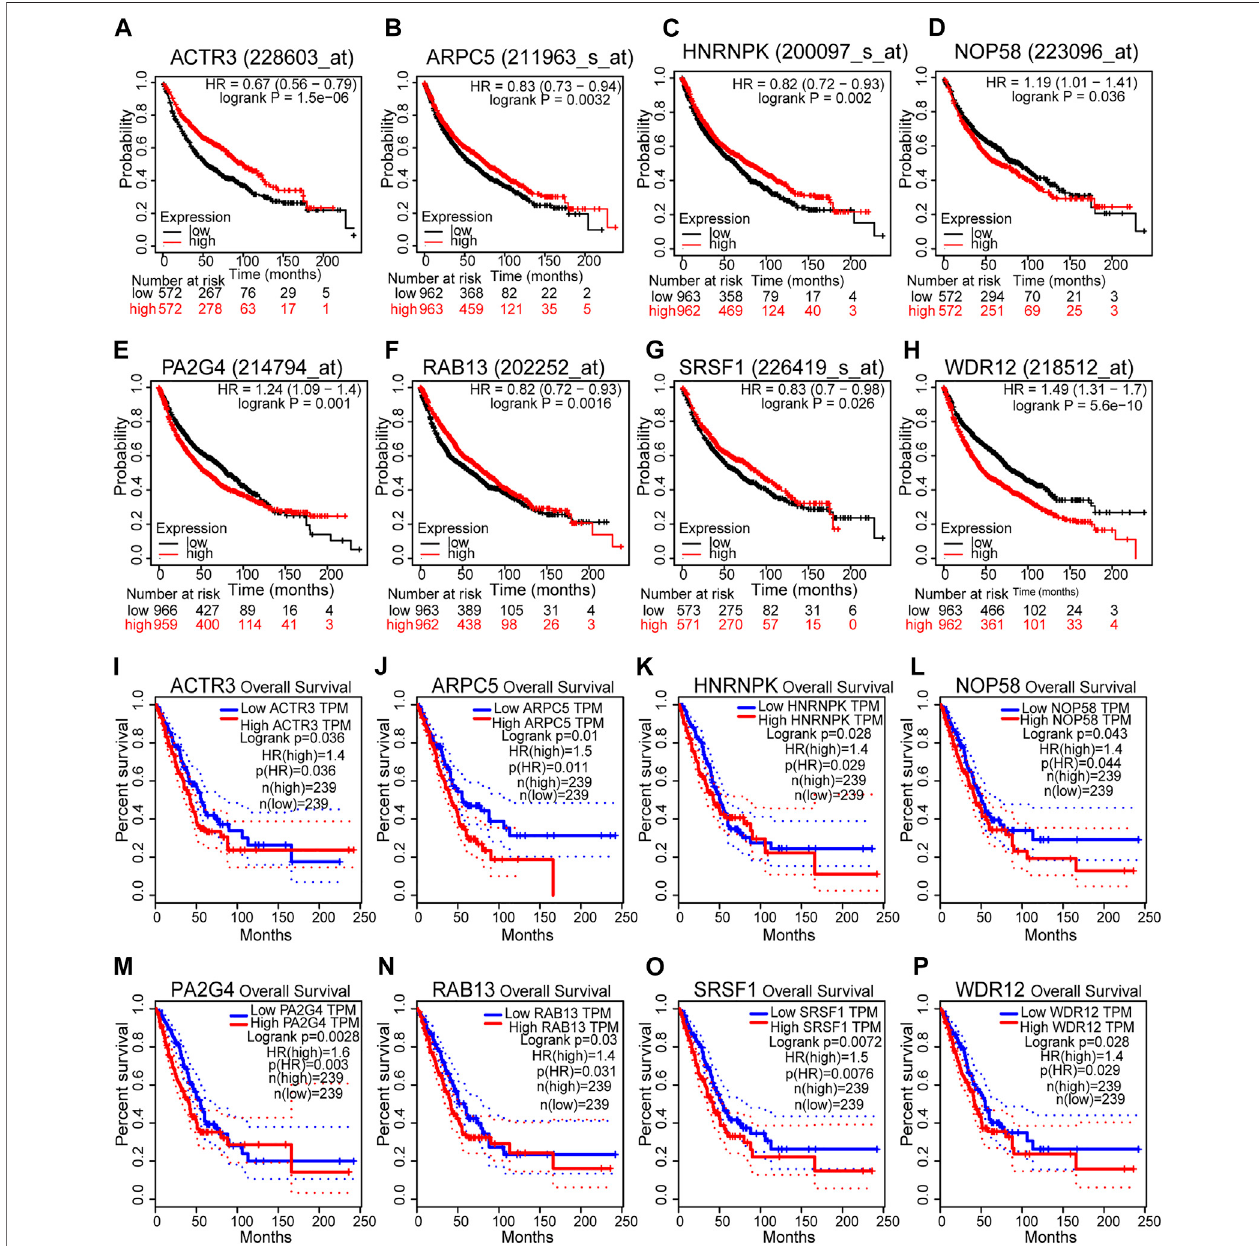
FIGURE 6 | Survival analyses of the eight hub gene candidates identi fi ed. (A – H) Overall survival of the eight hub gene candidates in lung adenocarcinoma (LUAD) based on Kaplan – Meier plotter. (I – P) Overall survival of the eight hub gene candidates in LUAD based on the Gene Expression Pro fi ling Interactive Analysis (GEPIA) database. p < 0.05 was considered to indicate a statistically signi fi cant difference. ACTR3, actin-related protein 3; ARPC5, actin-related protein 2/3 complex subunit 5; HNRNPK, heterogeneous nuclear ribonucleoprotein K; NOP58, NOP58 ribonucleoprotein; PA2G4, proliferation-associated 2G4; RAB13, RAB13 member RAS oncogene family; SRSF1, serine- and arginine-rich splicing factor 1; WDR12, WD repeat domain 12.